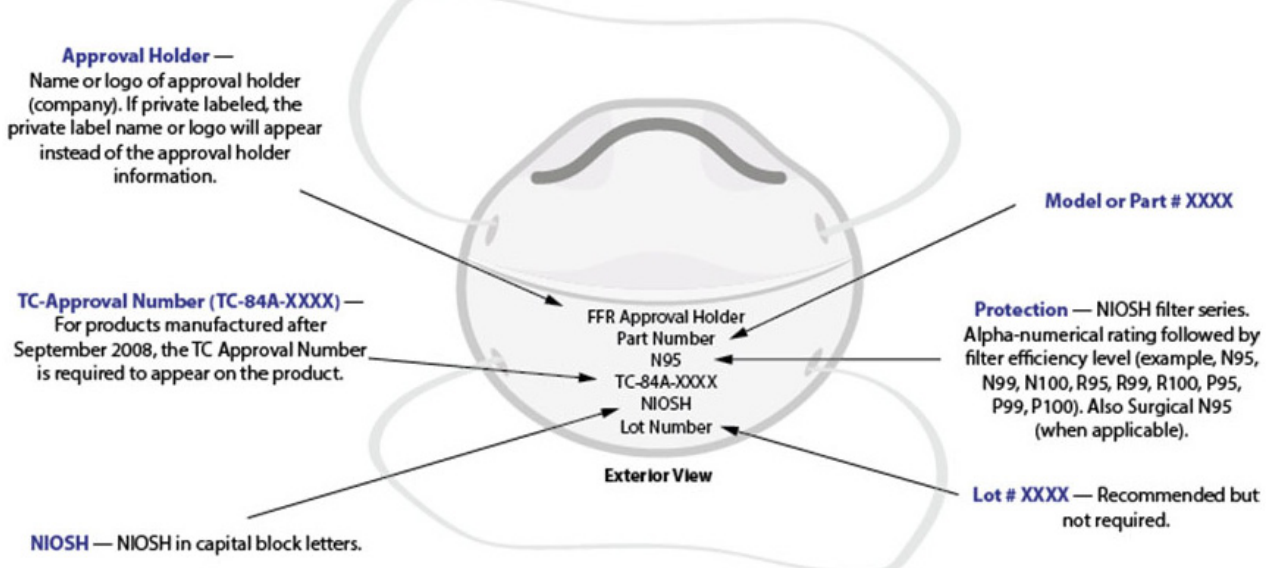
Figure 2. Model of a generic filtering respirator with appropriate markings [51].